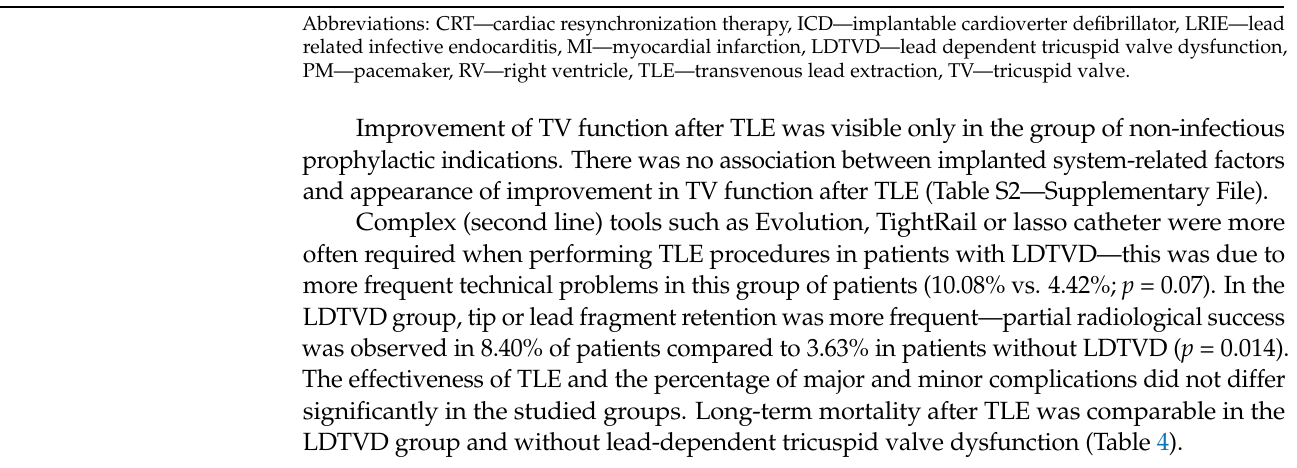
Table 4. TLE procedure complexity, efficacy, complications, outcomes and long-term mortality after TLE. Classification according to the occurrence of